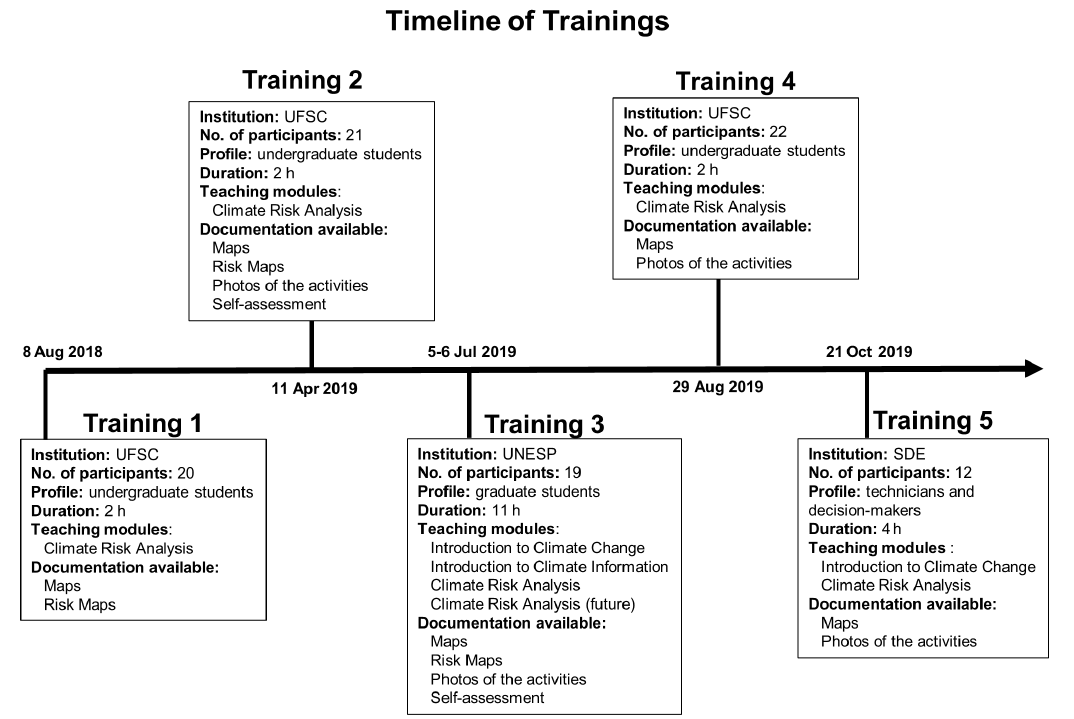
Figure 5. Description of the five trainings delivered during 2018 and 2019. Training 1, 2, and 4 addressed undergraduate students from UFSC; training 3 comprised graduate students from UNESP; training 5 was made up of practitioners from the SDE.